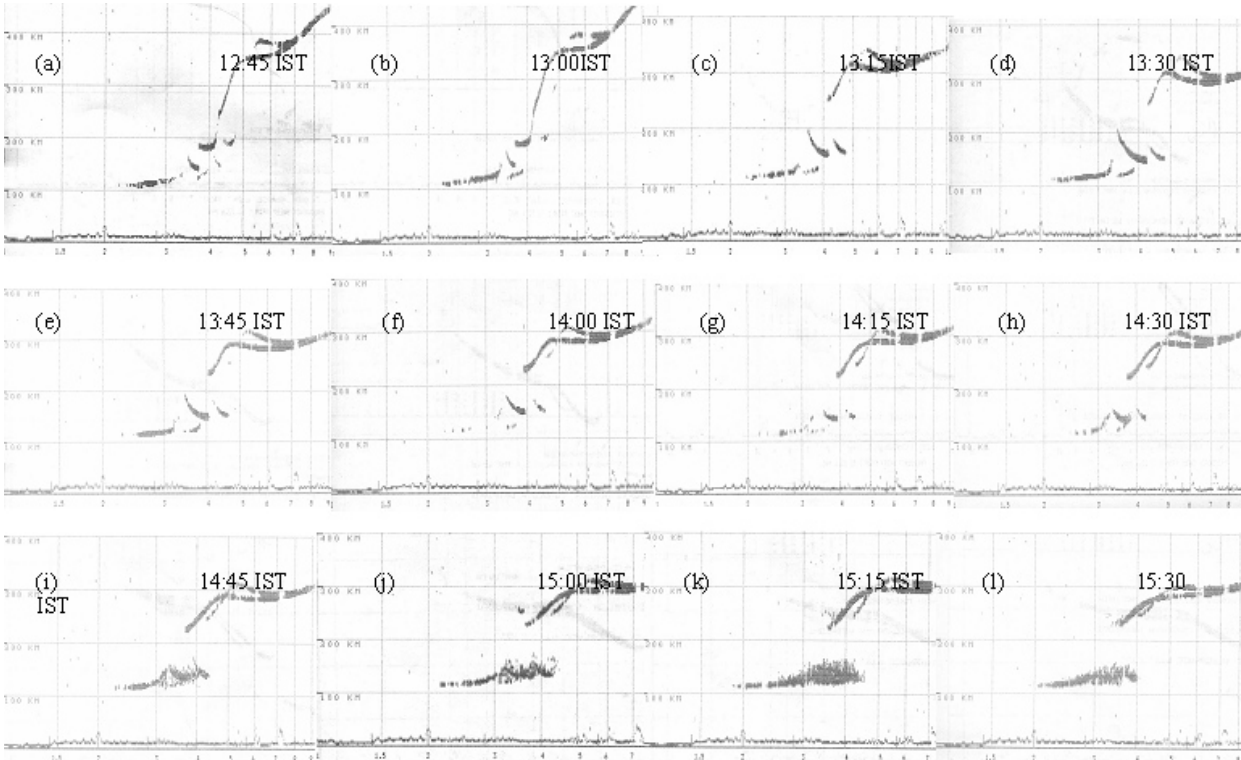
Fig. 1b. Sample Ionograms showing the daytime descending intermediate layers at Waltair during 12:45 to 15:30IST on 30 January 2004.